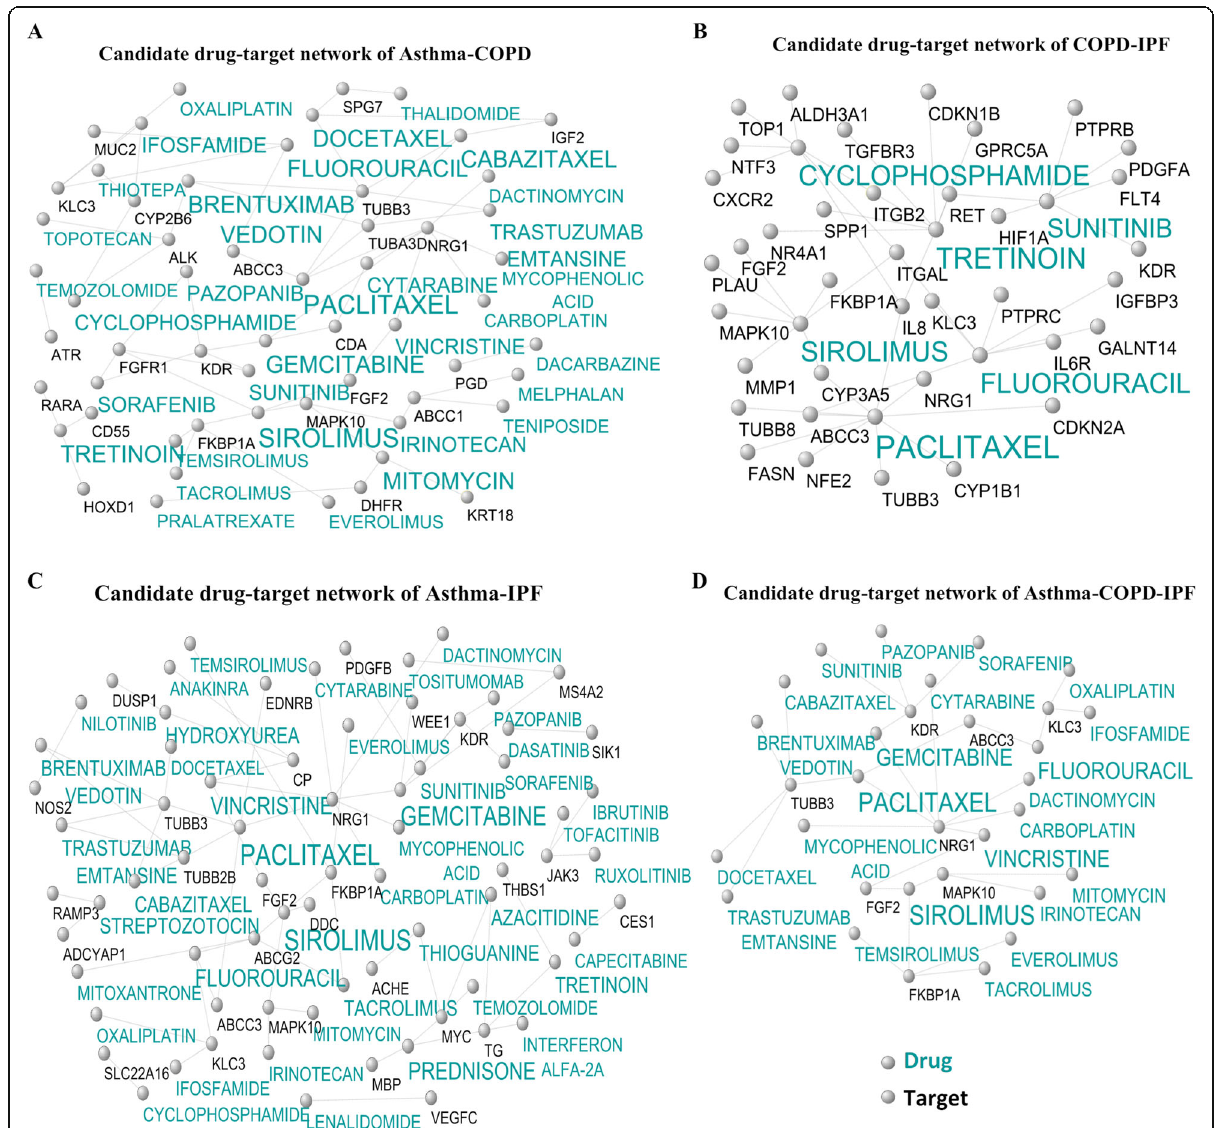
Fig. 8 Candidate shared drug-target networks. Label targets and drugs are colored with black and turquoise, respectively. The size of drug letters represents the degree of drug. a Candidate drug-target network of asthma-COPD, b Candidate drug-target network of asthma-IPF, c Candidate drug-target network of COPD-IPF, and d Candidate drug-target network of the